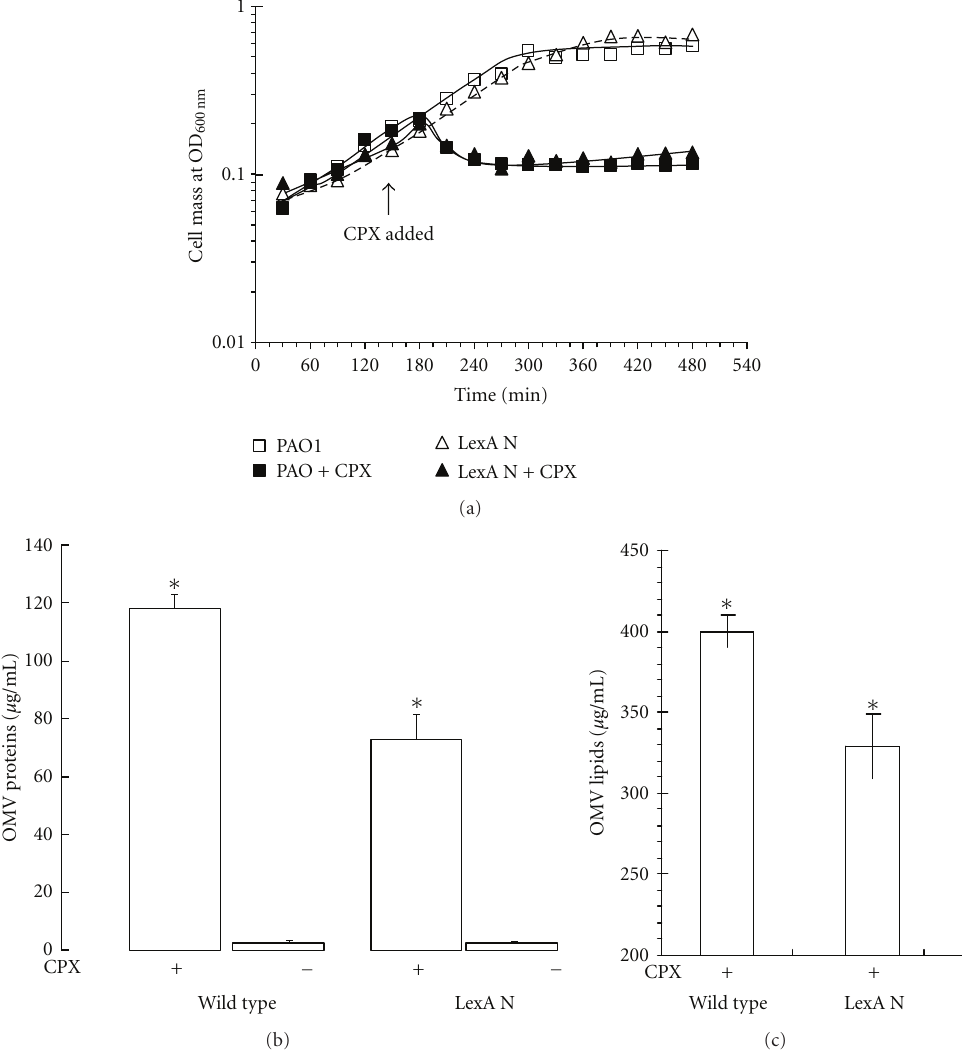
Figure 3: OMV production from P. aeruginosa under the ciprofloxacin-induced SOS response. (a) Growth of the wild-type (PAO1) and the LexA noncleavable strains. Both strain were grown in LB with shaking for 2 hrs, and then ciprofloxacin (CPX) was added. The culture continued for 6 hrs. OMVs were isolated from the wild-type and the lexAN cells treated with or without ciprofloxacin (CPX). (b) Quantification of OMV proteins by Bradford ( n = 7) and (c) OMV lipids by weight ( n = 3). ( ∗ P < 0 . 05).